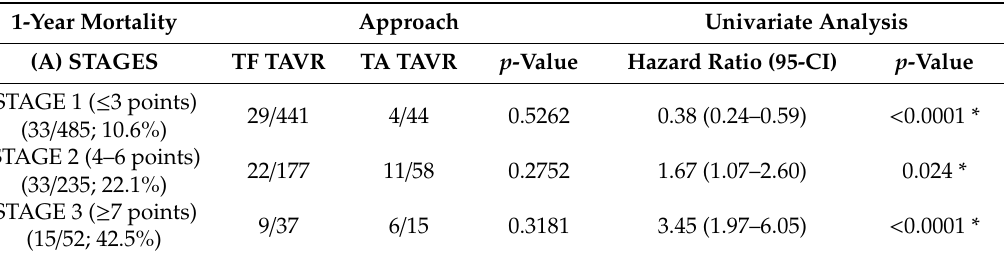
Table 2. Details of staged mortality risk